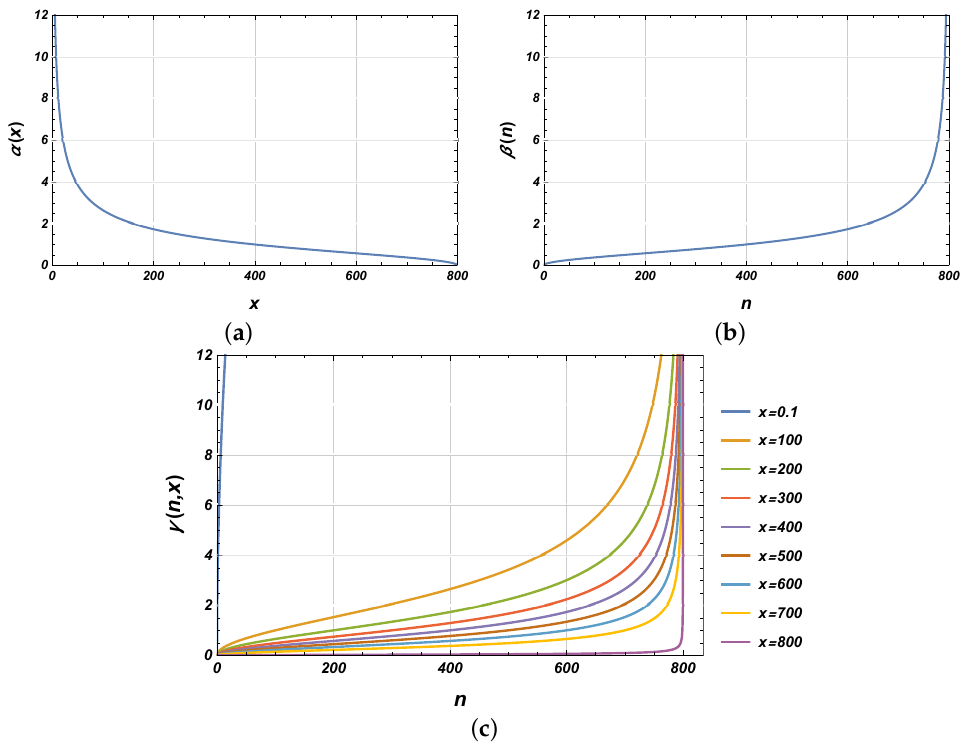
Figure 7. The plots of the KPs’ coefficients in (23): ( a ) plot of α ( x ) with respect to x , ( b ) plot of β ( n ) with respect to n , and ( c ) plot of γ ( n , x ) with respect to n with different values of x . Assuming p = 0.5 and N =